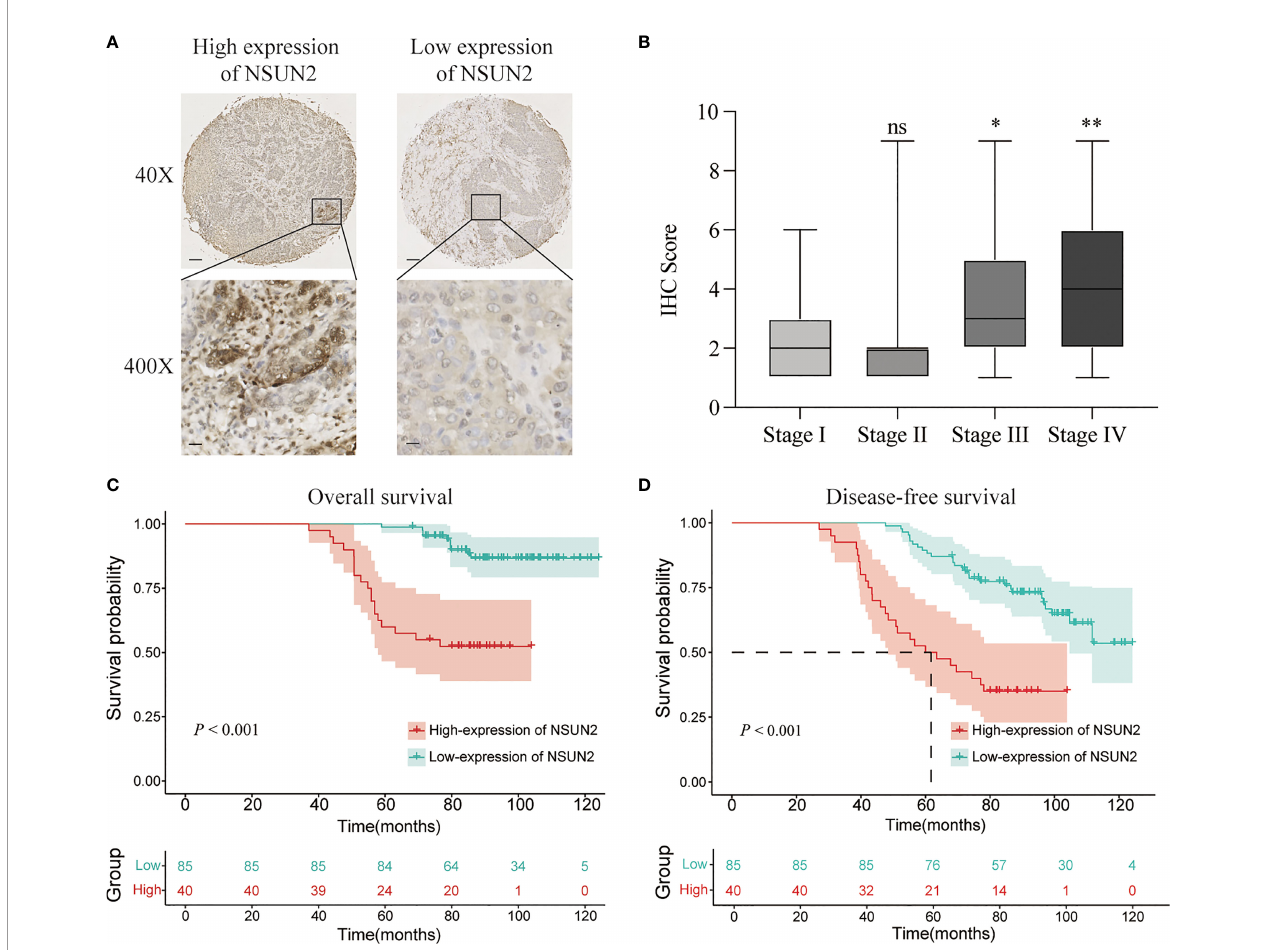
FIGURE 2 | NSUN2 is expressed in the nucleus and predicts a poor prognosis of NPC patients. (A) Representative immunohistochemical staining of NSUN2 in NPC TMA. Brown indicates positive staining (×40: scale bar = 100 m m; ×400: scale bar = 10 m m). (B) Correlation between the NSUN2 expression and TNM stage. Kaplan – Meier curves for OS (C) and DFS (D) of NPC patients with NSUN2 expression. * P < 0.05 and ** P < 0.01. ns, no signi fi